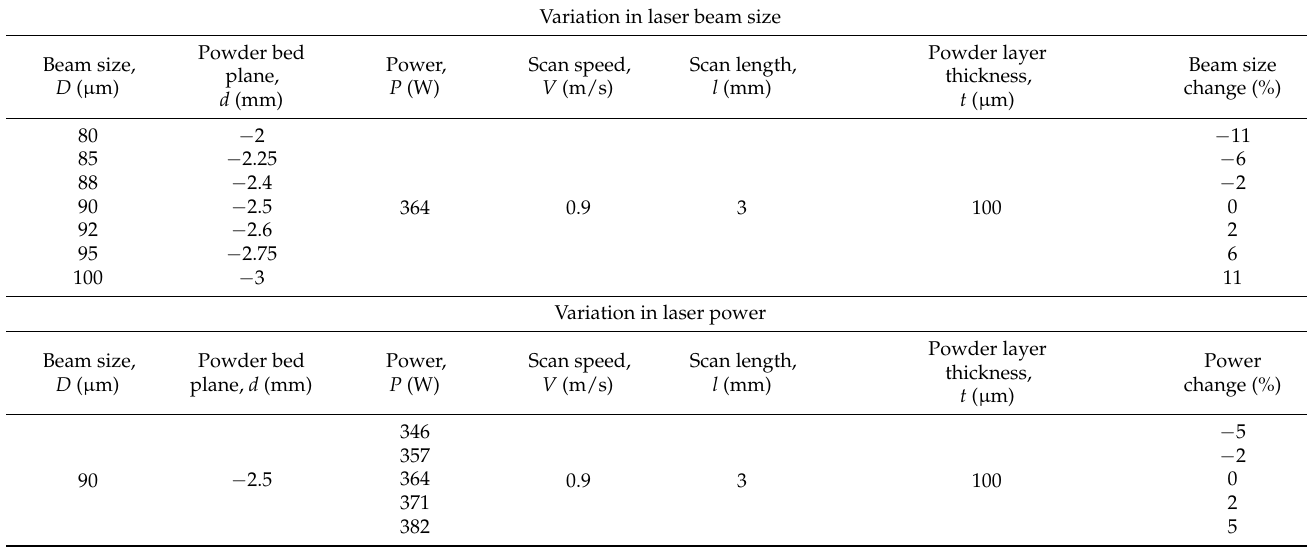
Table 2. Experimental processing parameters for SLM of Ti6Al4V. Powder bed plane is indicated by the distance from the focal plane of the laser (negative sign indicates that the powder bed plane is below the focal plane of the